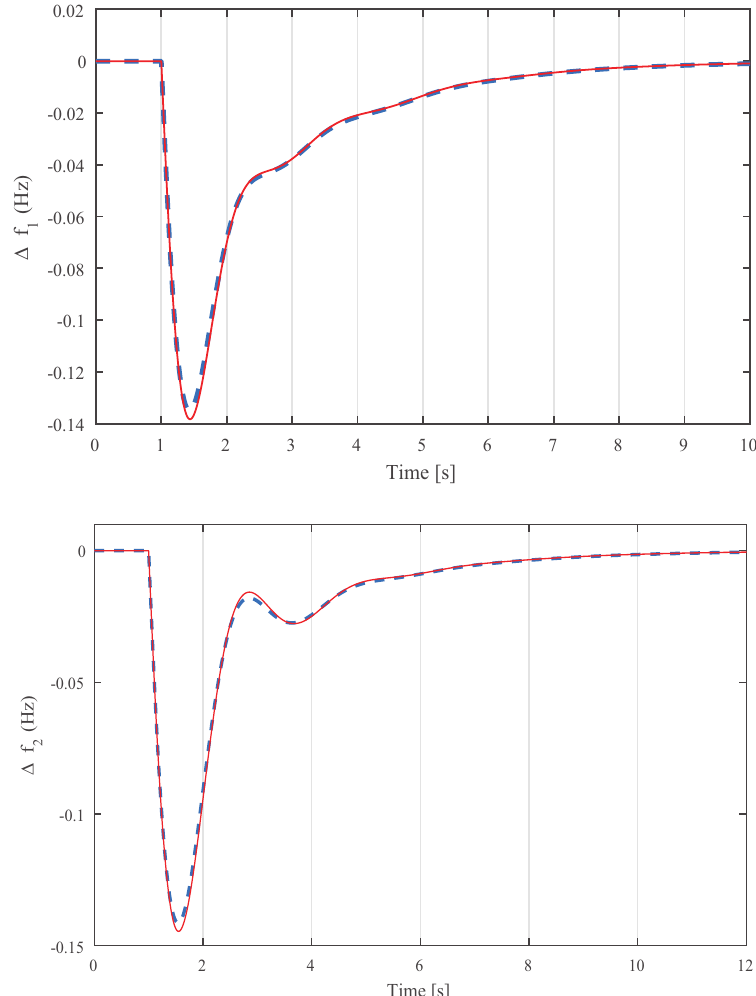
Figure 9. Responding curves of V2G system subjected to SOC(solid: 1.2 multiples, dashed: 0.8 multiples).